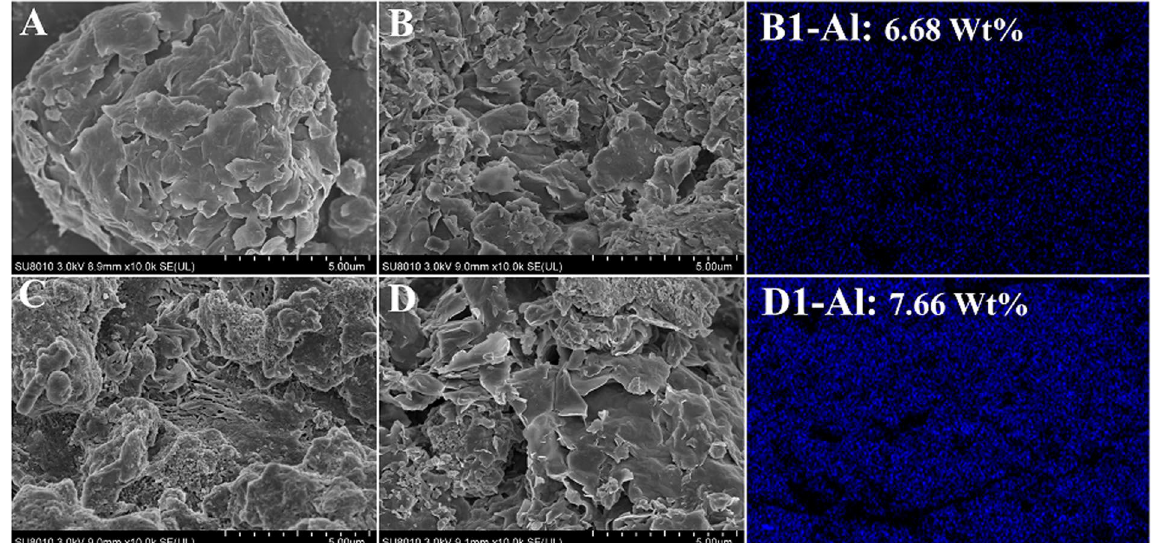
Figure 4. Scanning election micrographs and element surface distribution graphs of Al: ( A ) bentonite, ( B ) and (B1) organobentonite in the one-step process, ( C ) flocs in PAC coagulation, ( D ) and (D1) organobentonite in the one-step process with PAC.